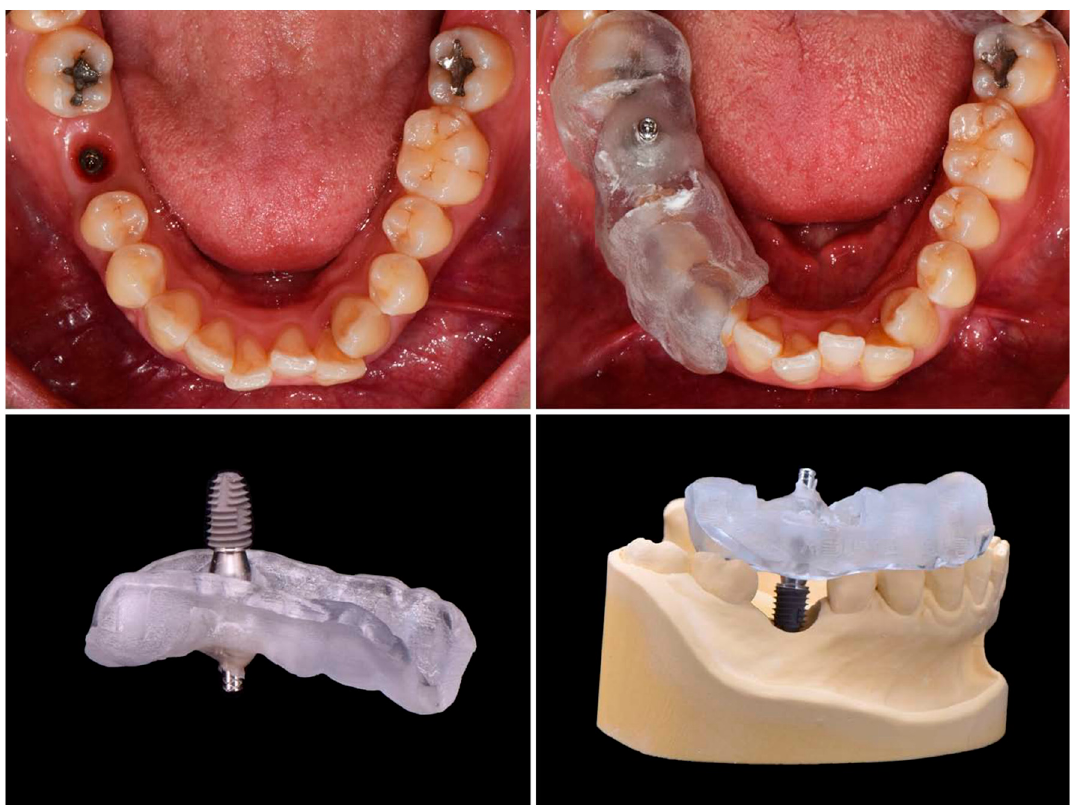
Figure 3. If the insertion torque is stable after implant surgery, the implant placed position can be determined using a surgical template immediately. The surgical template should be able to hold the impression coping connected to the placed